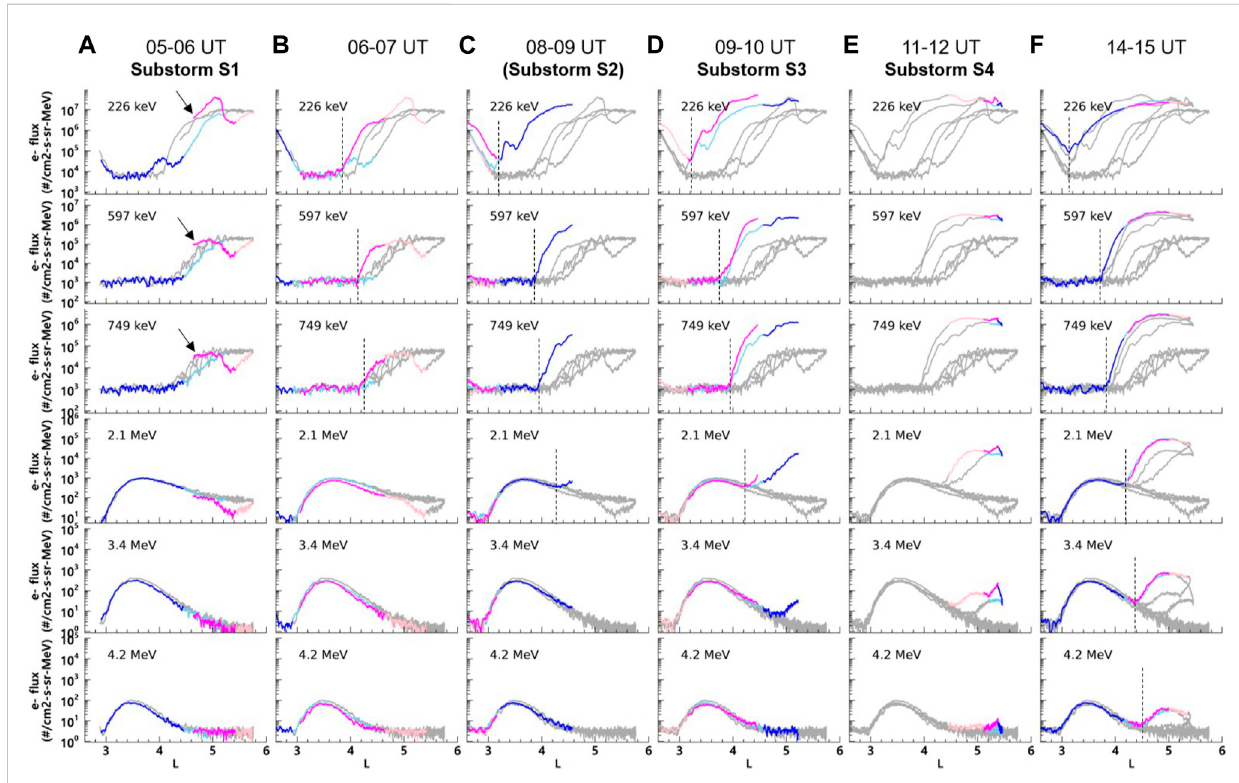
FIGURE 3 (A – F) Hourly fl ux snapshots for various energies from 226 keV to 4.2 MeV for six different